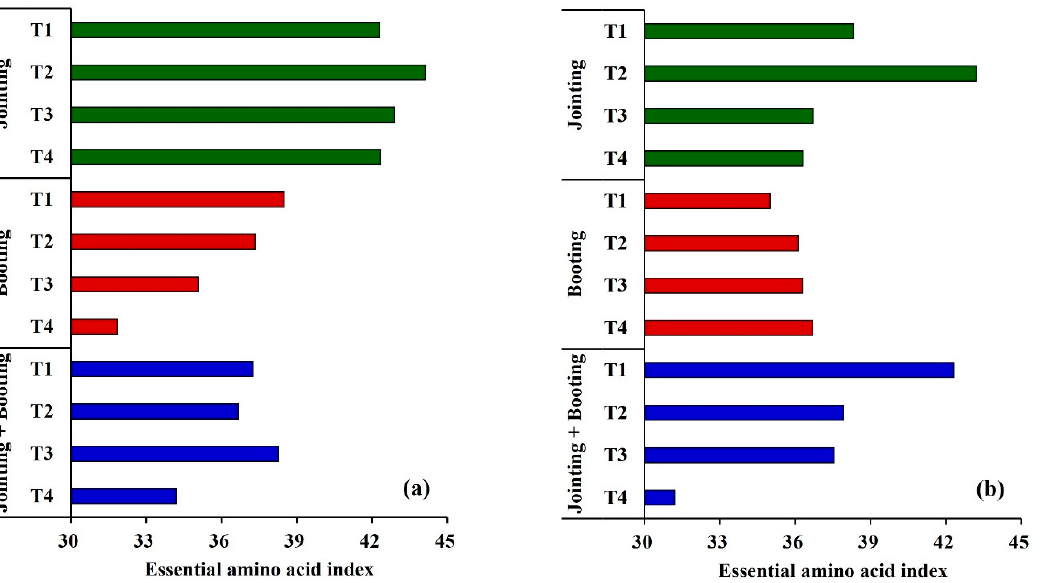
Figure 8. Effects of different low-temperature intensities and stages on the essential amino acid index of Yangmai16 ( a ) and Xumai30 ( b ).